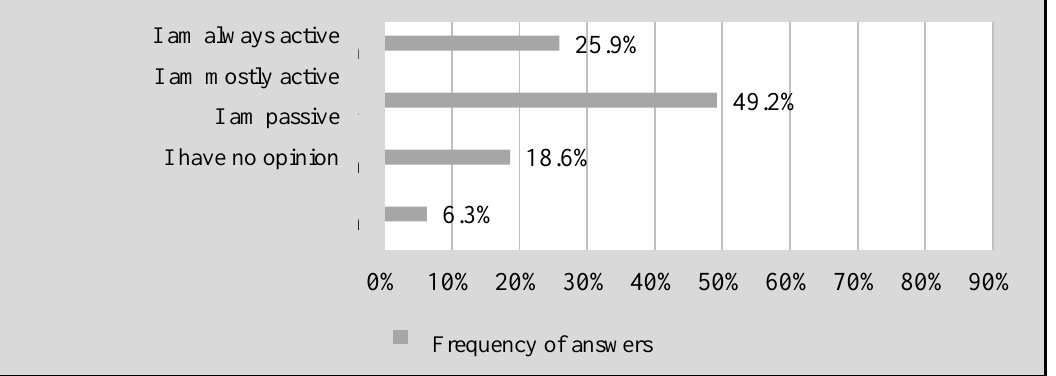
Figure 2. How do you evaluate your participation in religious education? (Source: own study).